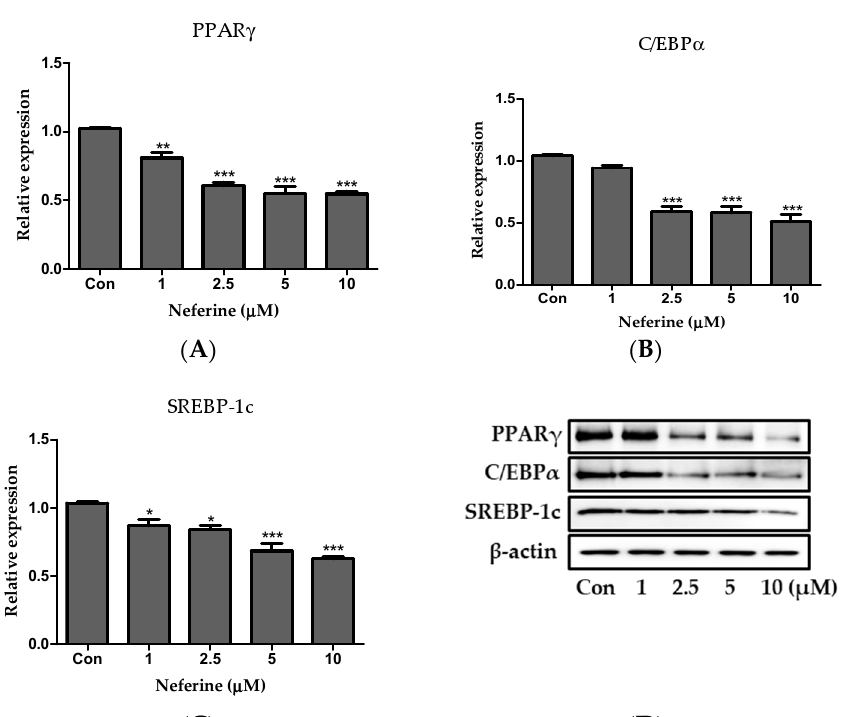
Figure 6. Effects of neferine on AMPK and ACC during the differentiation of 3T3-L1 adipocytes. Ratios of relative expression levels of ( A ) p -AMPK/AMPK and ( B ) p -ACC/ACC are presented. * p < 0.05, ** p < 0.01, and *** p < 0.001 vs. Con. All data are presented as mean ± SD, and experiments were performed at least thrice. The positive control (Con) was differentiated 3T3-L1 cells treated with adipocyte differentiation cocktail.